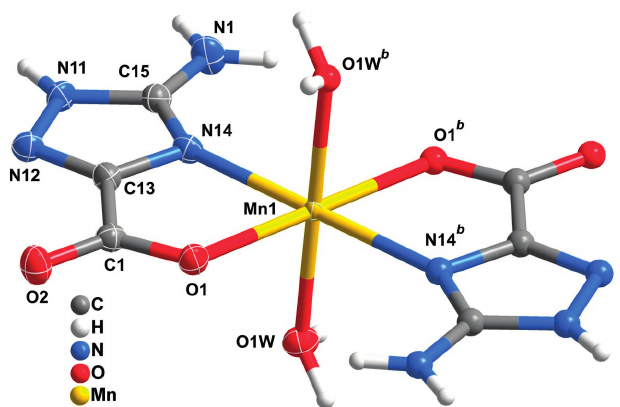
Figure 3. Mononuclear anionic complex [Mn(Hatrc) 2 (H 2 O) 2 ] found in 2 showing the labelling scheme for all non-H atoms composing the asu and the metallic coordination environment. Crystallographically independent non-H atoms are represented as thermal ellipsoids drawn at the 50% probability level. Symmetry-related atoms are represented as spheres with arbitrary radius. For selected bond lengths and angles see Table 1. Symmetry operation: b = 1 − x , 1 − y , 1 − z .